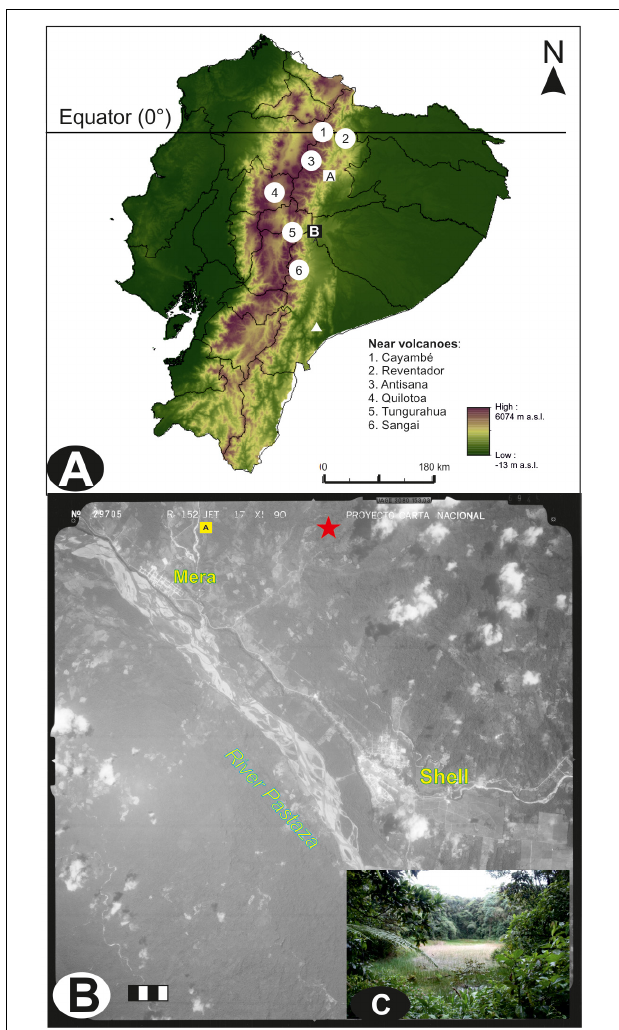
FIGURE 1 | Study area. (A) Map of Ecuador, showing the location, main Quaternary active volcanoes near the study site (circles), the speleothem Santiago record (triangle) and other sedimentary archives mentioned in the text (squares): (A) Vinillos (Loughlin et al., 2018), and (B) Mera and Laguna Pindo (the present study). (B) Aerial photograph of the specific study area showing the detailed location and proximity of Laguna Pindo (star) and the closest sequence Mera (square). Main geographical features including river (italics) and towns (bold) are also shown. Year of the photograph: 1990; scale 1:60,000 (bar = 1 km). Photograph obtained from the Ecuadorian Geographic Military Institute (IGM). (C) Picture of the lake where it can be observed the closed vegetation surrounding the lake’s edge (February